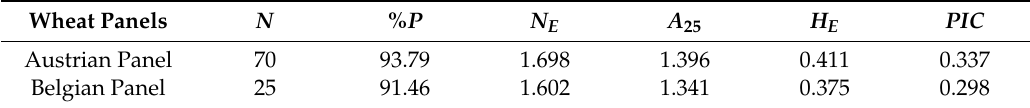
Genetic diversity of the Austrian and Belgian wheat breeding panels based on 1052 DArT